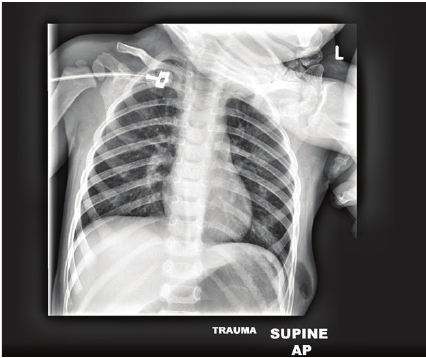
Figure 2: Chest radiograph reveals a tubular soft tissue lucency.